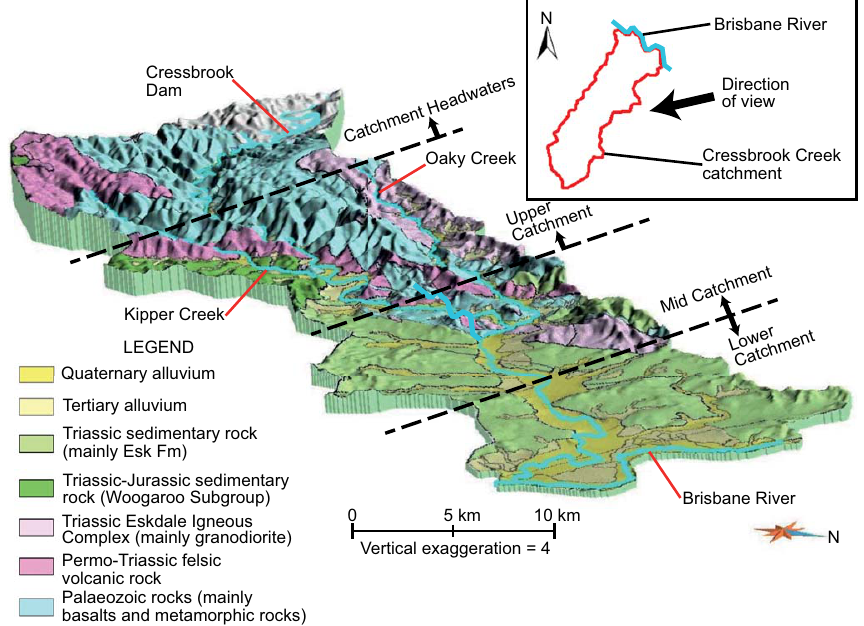
Figure 2. Geology, topography and surface drainages of the Cressbrook Creek catchment (viewed from the east; adapted from King et al.,